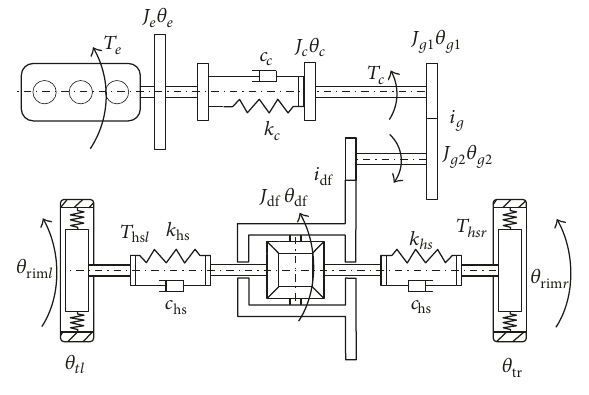
Figure 3: Structure of